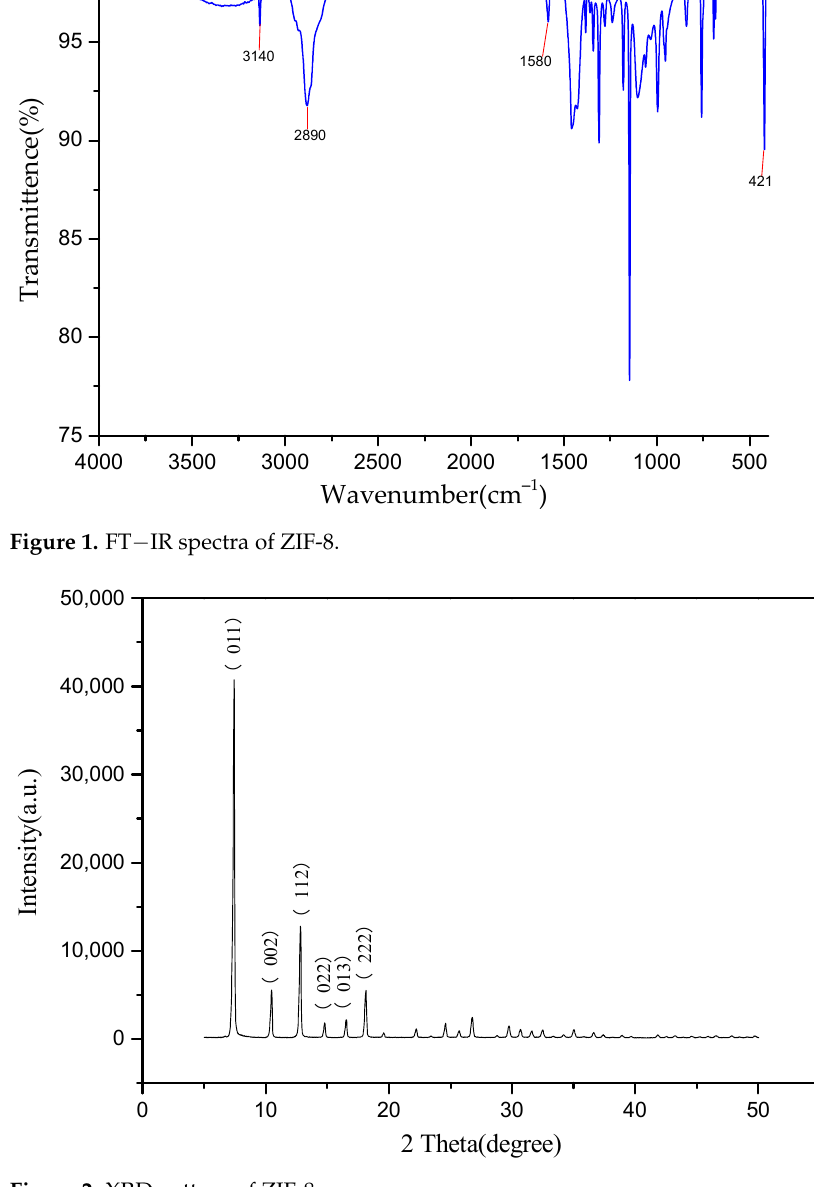
Figure 2. XRD pattern of ZIF-8. The specific surface area and pore size distribution of the sample were measured by a N 2 adsorption-desorption experiment at 77 K using the static volumetric method and 3H-2000 specific surface area tester. The specific surface area of ZIF-8 is 1458.166 m 2 /g, and the pore volume is 0.696 cm 3 /g. According to the pore size distribution diagram, the pore size of ZIF-8 is distributed around 29.7 nm, and the average pore size is 1.531 nm. As can be seen from the cumulative distribution in Figure 3, ZIF-8 particles are evenly distributed and concentrated in a range of 0–500 nm when the optimal condition reaction is adopted, and no large particles appear. ZIF-8 particles are mono-dispersed particles, indicating that 2-methylimidazole reduces the surface energy, hinders the collision between nanoparticles, and prevents Oswald dissolution in the nanoparticles. ZIF-8 particle size presents a partial distribution on the whole, which is appropriate as a solid